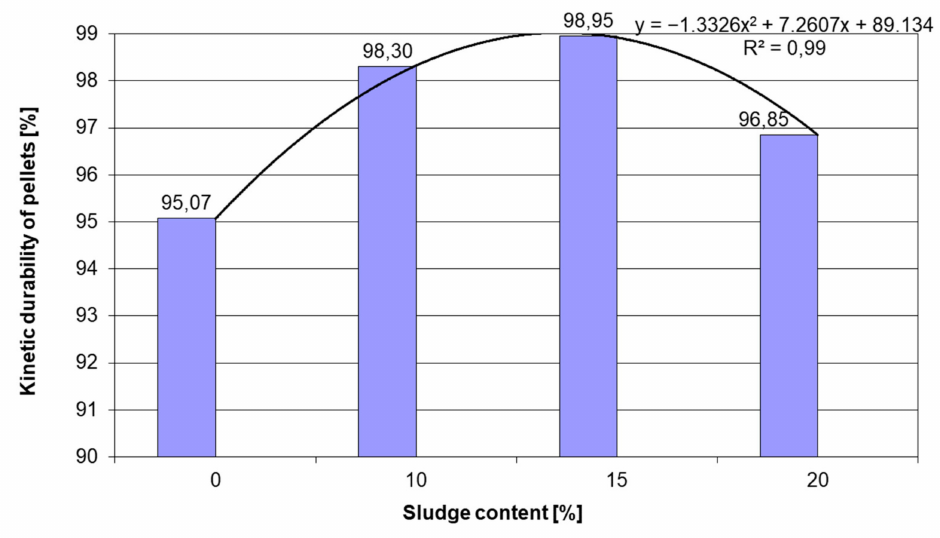
Figure 6. Dependence of the kinetic durability of pellets on the content of post-flotation dairy sewage sludge in the mixture with